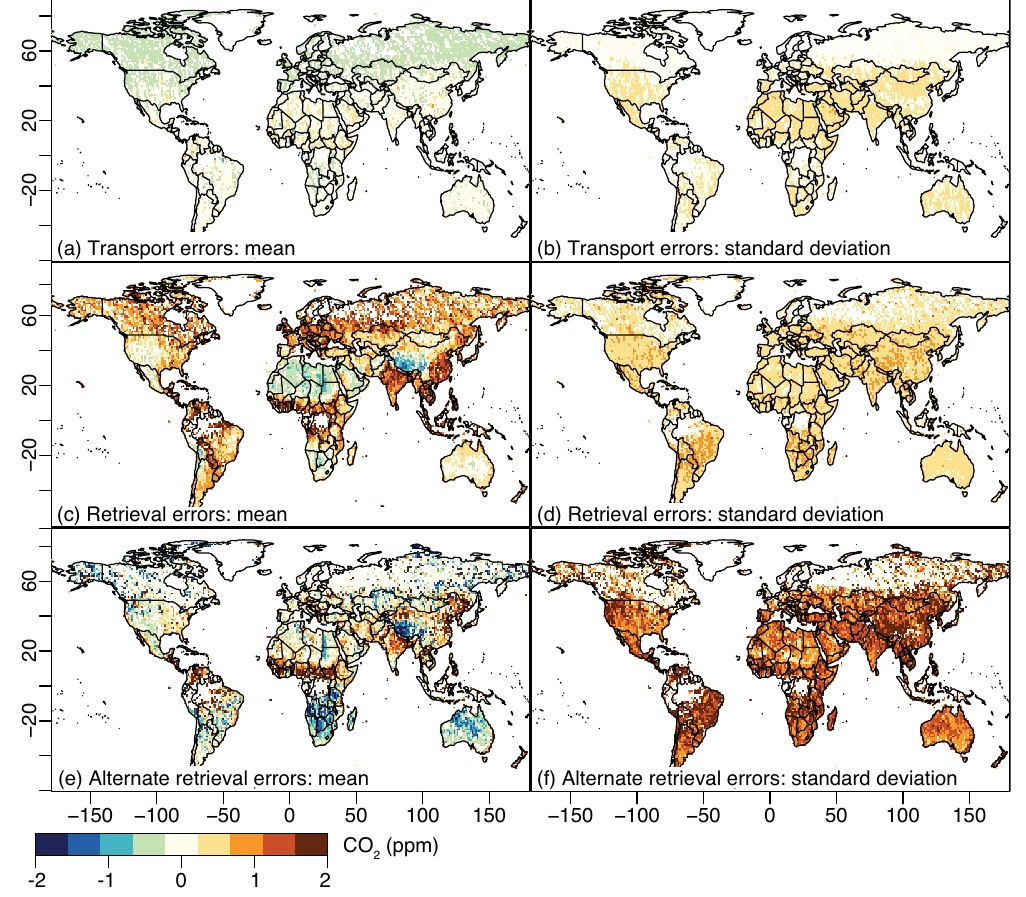
Figure 1. This figure displays the simulated synthetic data errors (i.e., simulated (cid:15) ): the simulated atmospheric transport errors (a–b) , the simulated retrieval errors (c–d) , and a second, alternative set of retrieval errors (e–f) . The left-hand panels display the mean of the errors within each PCTM grid box across the entire 2014–2015 study period, an indication of the correlation or covariance among the errors. By contrast, the right-hand panels display the standard deviation of the errors or residuals within each PCTM grid